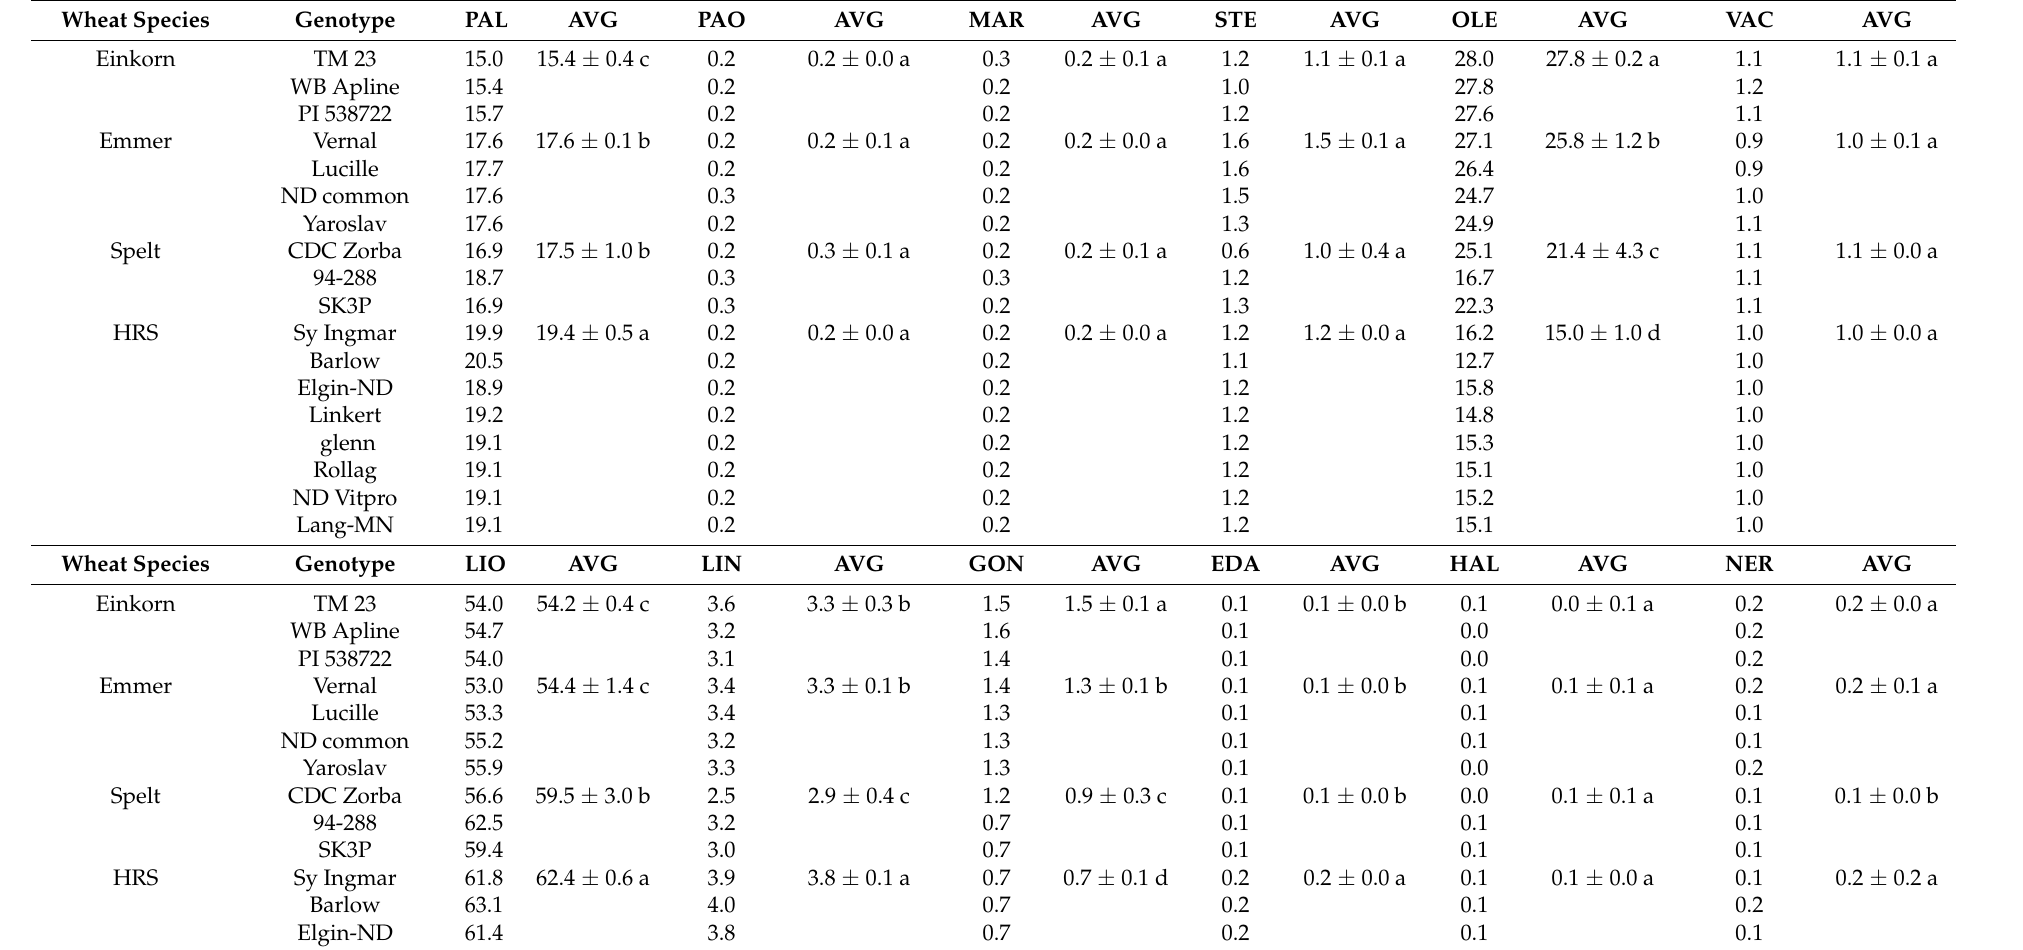
Table 3. Fatty acid composition of whole wheat flour of einkorn, emmer, spelt and hard red spring wheat. Wheat